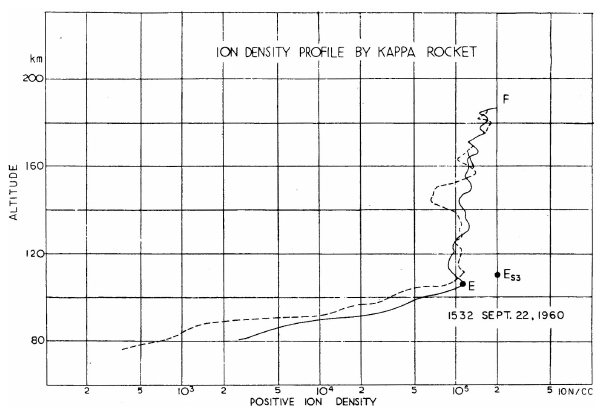
Figure 15. Electron density profile obtained at 15:32JST, 22 September 1960 by a K-8 rocket launched from Michikawa, Japan. (Reprinted from Planet. Space Sci., 9, Maeda, K. and Hi- rao, K.: A review of upper atmosphere rocket research in Japan, 355–369, Copyright 1962, with permission from Elsevier.)